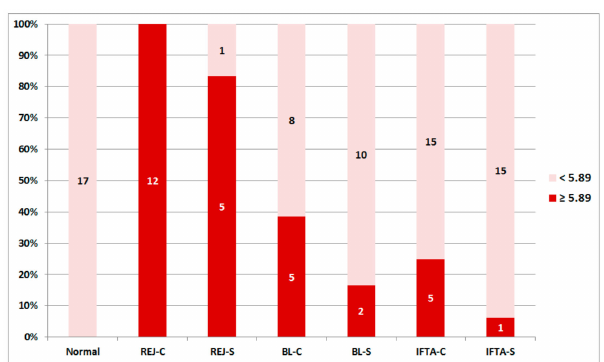
Figure 4. Positive ( ≥ 5.89) and negative ( < 5.89) rejection-associated gene score in the di ff erent histological categories in surveillance and for cause biopsies. The number of biopsies in each group according to the rejection-associated gene score is displayed. REJ-C, rejection in biopsies for cause; Normal, normal surveillance biopsies, REJ-S, rejection in surveillance biopsies; BL-C, borderline changes in biopsies for cause; BL-S, borderline changes in surveillance biopsies; IFTA-C, interstitial fibrosis and tubular atrophy in biopsies for cause; IFTA-S, interstitial fibrosis and tubular atrophy in surveillance biopsies.